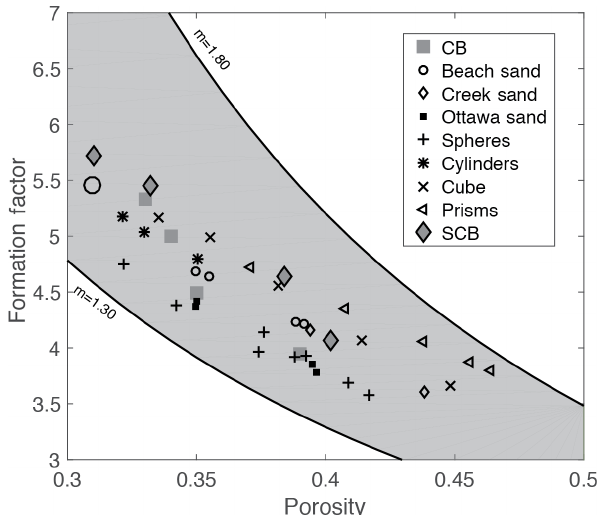
Figure 15. Comparison between laboratory results (open symbols) and end-computed results (plain symbols). The trends in dashed lines are obtained from the laboratory-measured